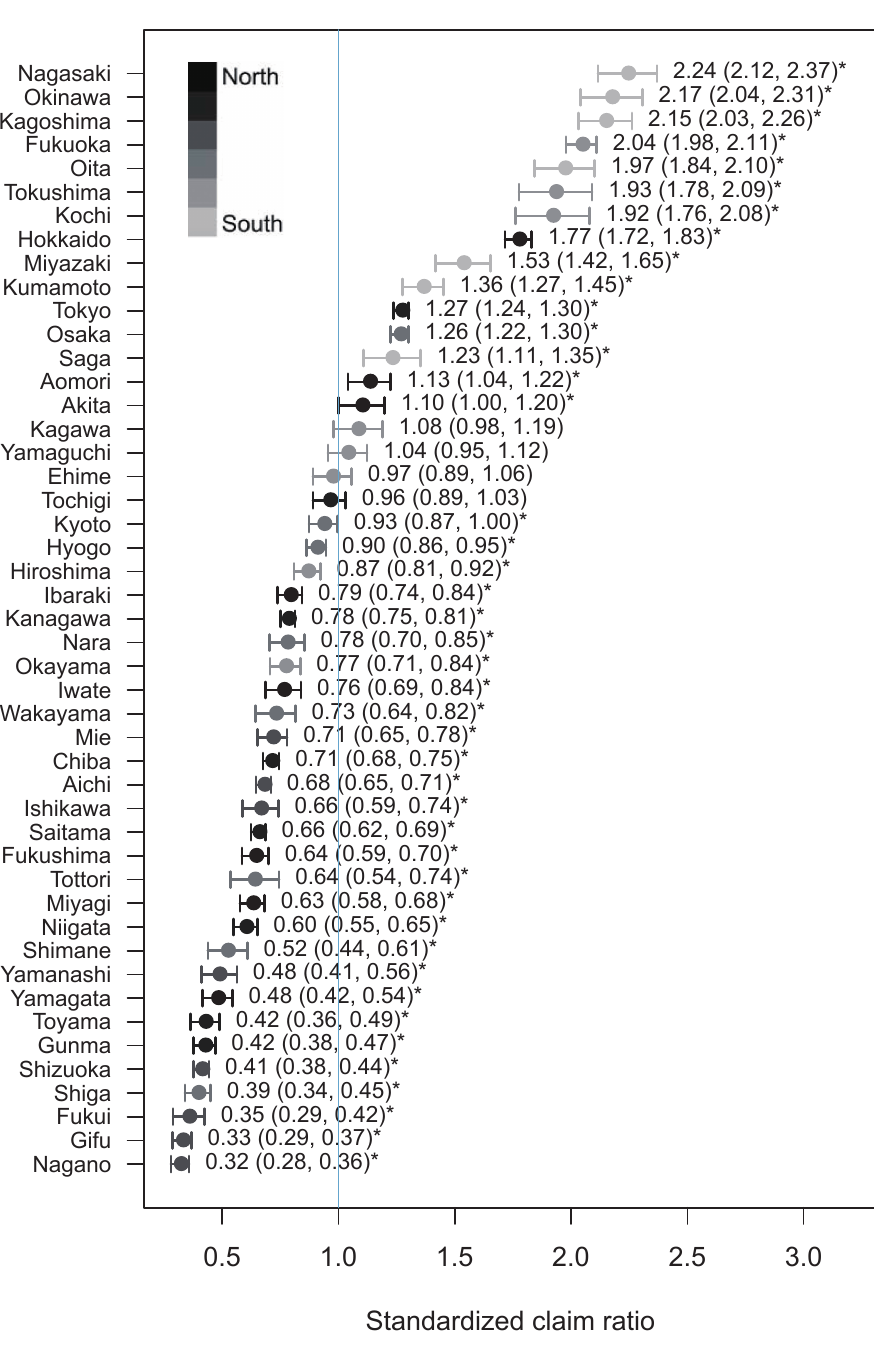
Figure 2. Age- and sex-standardized claim ratio of the number of psychiatric admissions among recipients of public assistance for each of the 47 prefectures. * Indicates a statistically signi fi cant di ff erence from Japan ’ s national